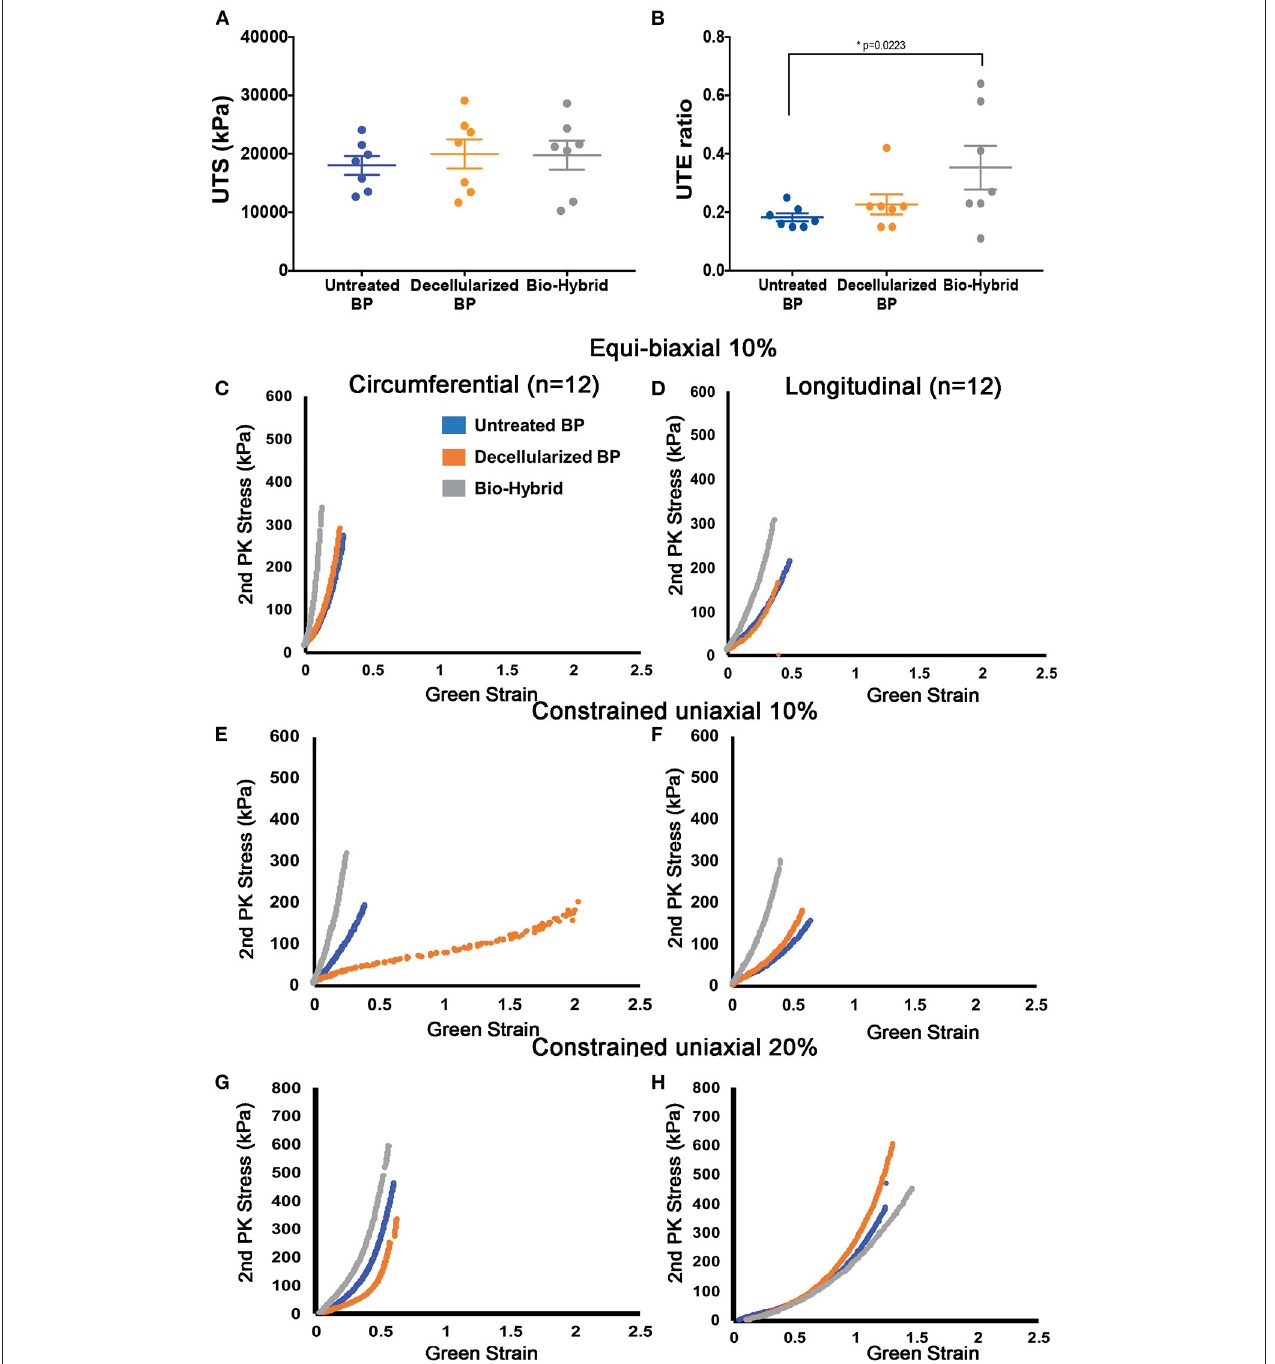
FIGURE 5 | In-vitro mechanical properties of the untreated BP, decellularized BP, and the biohybrid composite. (A,B) Uniaxial tensile strength (kPa) and uniaxial tensile extensibility ratio of the materials showing no difference in the tensile strength and a significant increase in the extensibility in the biohybrid, (C,D) equibiaxial (10%) testing of the three groups showing a stiffer response of the biohybrid in both the circumferential and longitudinal directions and similar response of the fresh BP and decellularized BP, (E,F) step biaxial testing with 10% strain in the direction of testing showing stiffer response of the biohybrid than the other two groups in both the directions whereas the decellularized BP is more compliant in the circumferential direction, and (G,H) step biaxial testing with 20% strain in the direction of testing showing stiffer response of the biohybrid in the circumferential direction followed by the untreated BP and decellularized BP and longitudinal direction shows stiffer response of the decellularized BP with absence of aligned polymer nanofibers in the biohybrid.